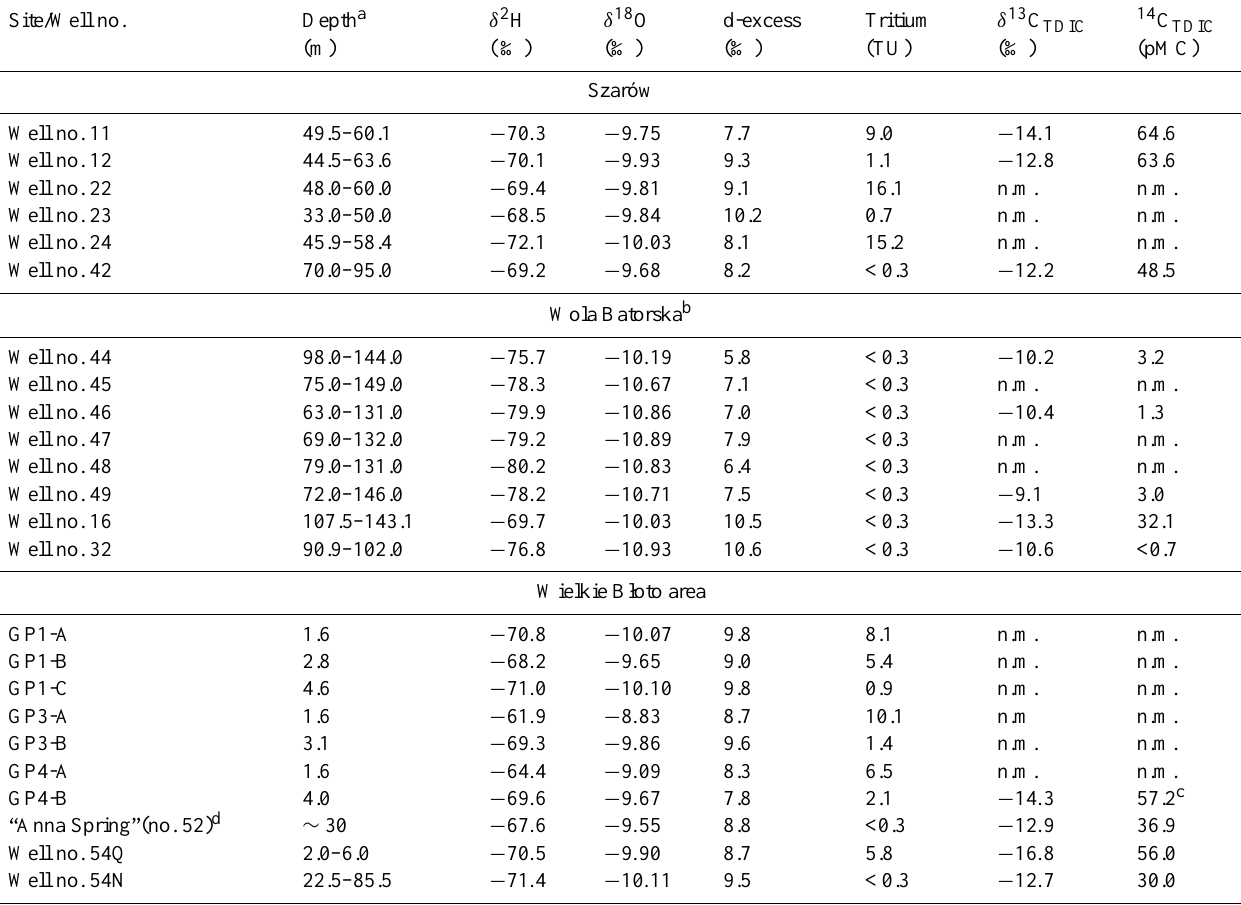
Table 1. Environmental tracer data for groundwater samples collected in the study area (n.m.: not measured). Site/Well